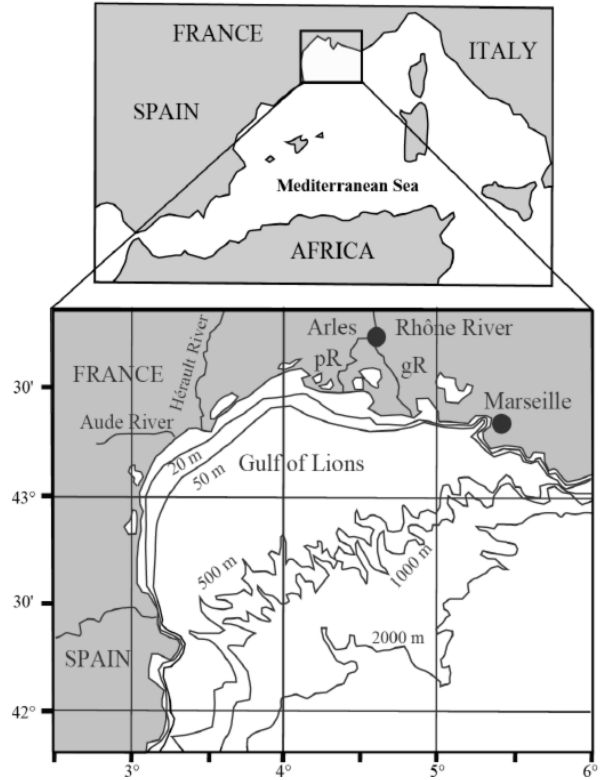
Figure 1. Rhône River mouth area and sampling location: “Arles”. gR and pR denote grand Rhône and petit Rhône which are the two arms of the river.